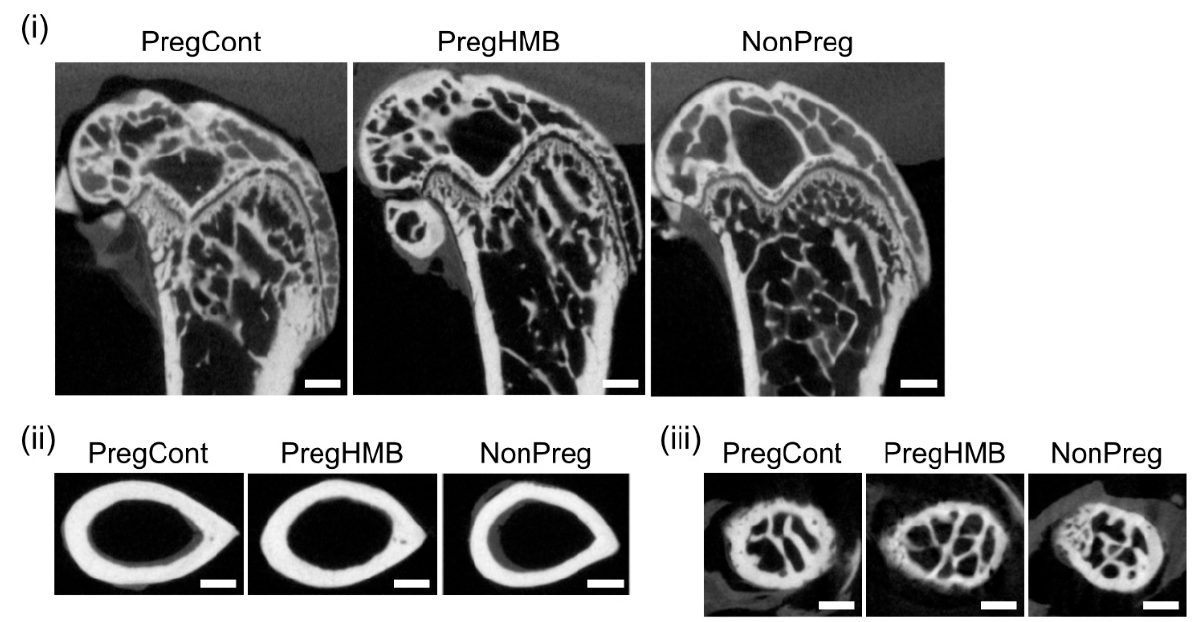
Figure 1. Representative micro-CT images of sagittal sections of the right femur distal diaphysis ( i ), transverse sections of the femur mid-shaft ( ii ), and transverse sections of the femoral neck ( iii ) from pregnant (control and supplemented with β -Hydroxy β -methylbutyrate (HMB)) and non-pregnant female spiny mice. PregCont—control pregnant females (not receiving HMB); PregHMB—pregnant HMB females (receiving HMB at a dose of 0.02 g/kg b.w. during the middle trimester of pregnancy); NonPreg—non-pregnant females. Scale bars represent 500 µm.